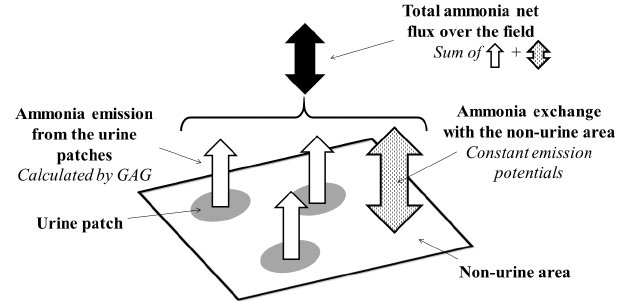
Figure 4. The schematic of GAG_field. The figure depicts the com- ponents of the total net NH 3 flux over the field: NH 3 emission from the urine patches and the NH 3 exchange with the non-urine